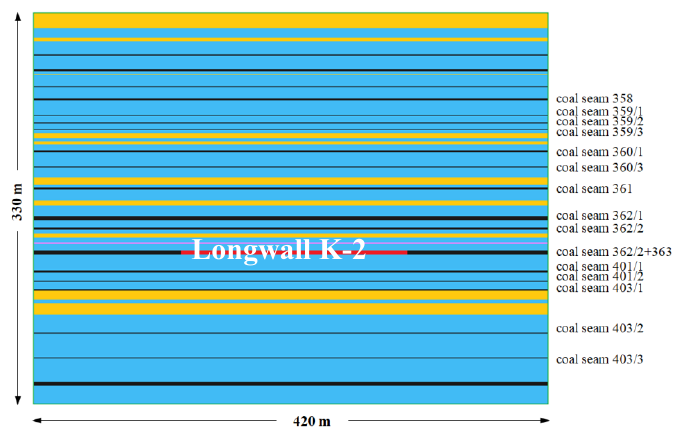
Figure 14. Numerical model of the rock mass surrounding the mined longwall K-2, in coal seam 362/3 + 363.